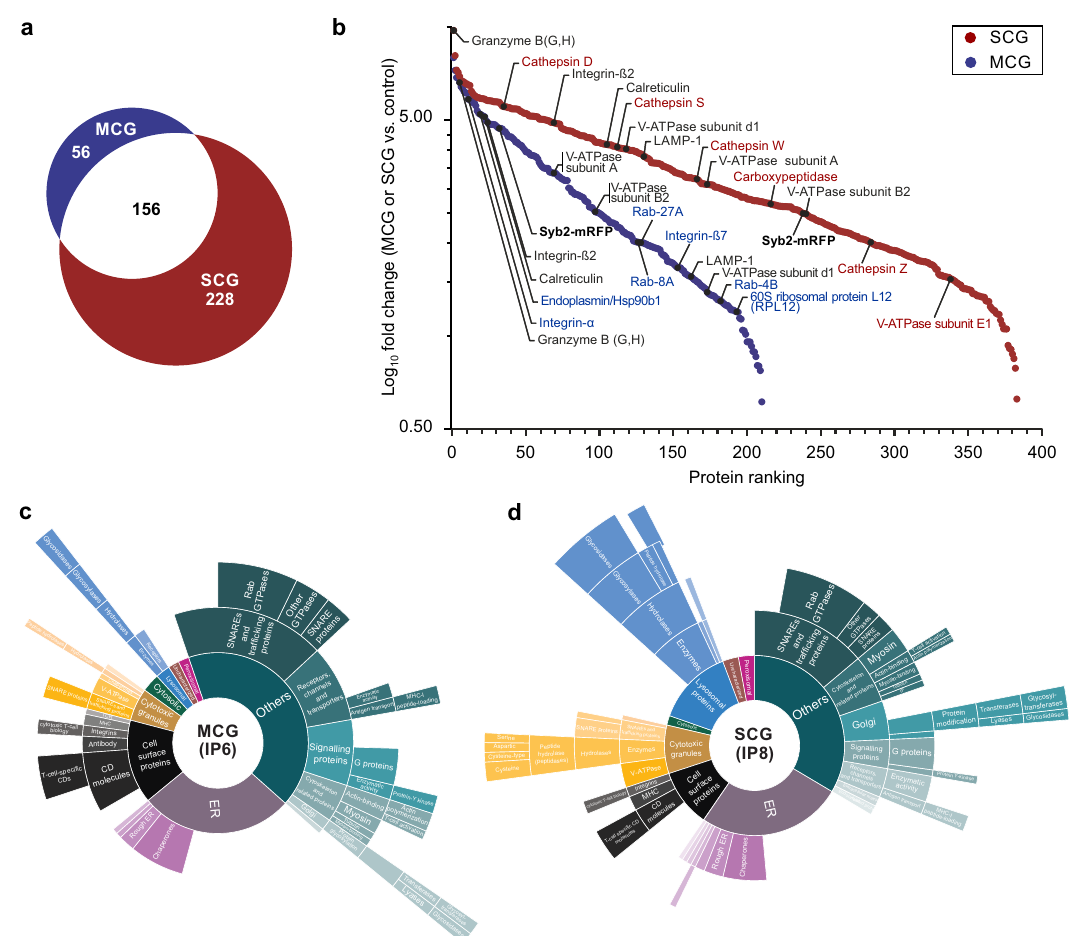
Fig. 4 Multi core granules (MCG) and single core granules (SCG) exhibit a different protein composition as detected by mass spectrometry. a Venn diagrams of all proteins identi fi ed from MCG and SCG. 56 proteins were unique in MCG and 228 proteins were unique in SCG, while 156 proteins were found in both classes. b Ranked abundance plot of signi fi cantly enriched proteins in the proteome of MCG and SCG. Signi fi cantly enriched proteins in MCG (blue dots) and SCG (red dots) compared to the naive cell control plotted as Log 10 fold change against the ranked protein abundance. Proteins speci fi cally found in MCG and SCG are shown in blue and red, respectively. The common proteins are labeled in black. c , d Gene ontology analysis and manual annotation of enriched gene ontology terms. Annotations (cellular localization and biological function) assigned to the enriched gene ontology terms in MCG ( c ) and SCG ( d ) were conducted manually in agreement with current literature and database evidence. The inner core segments (e.g., lysosomal proteins, endoplasmic reticulum, cytosolic, etc.) of the sunburst plots represent the annotations based on cellular localization of the proteins. Of note, the size of each segment corresponds to the number of genes associated with this annotation term. Outer segments indicate biological functions of the proteins from the main categories. Five and three biological and technical replicates were performed for IP6 and IP8,